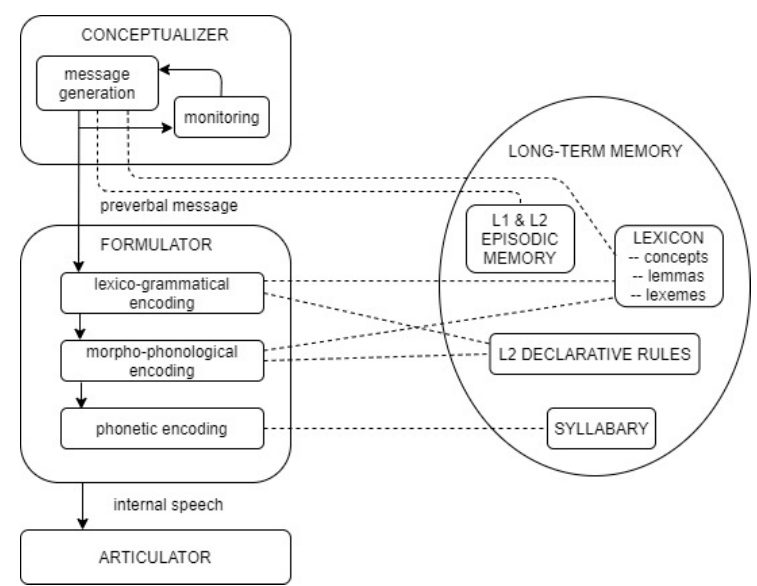
Figure 1. The Model of Bilingual Speech Production (adapted from Kormos 2006, p. 168).